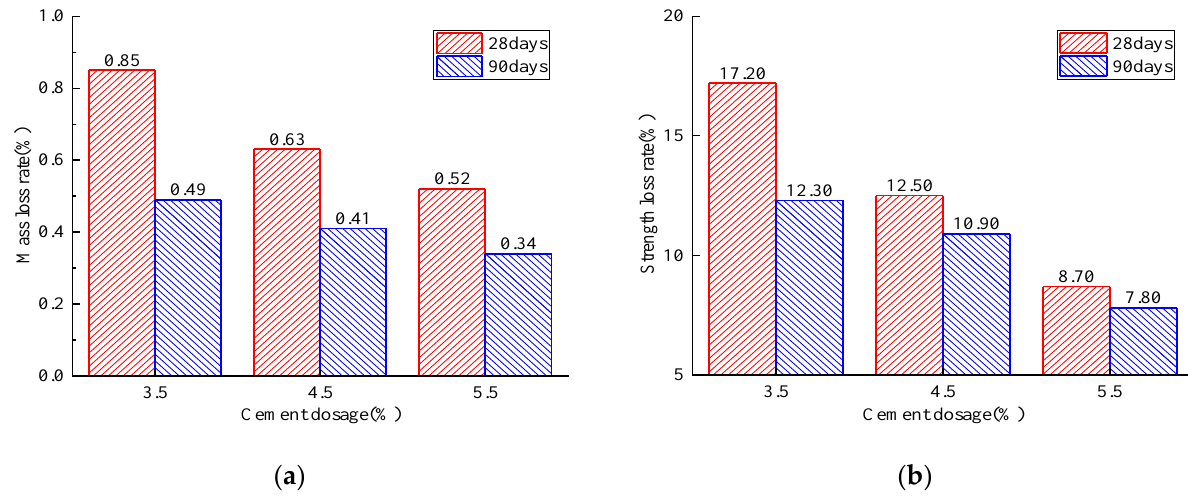
Figure 20. Analysis of the freeze–thaw-cycle test: ( a ) mass loss rate; ( b ) strength loss rate.